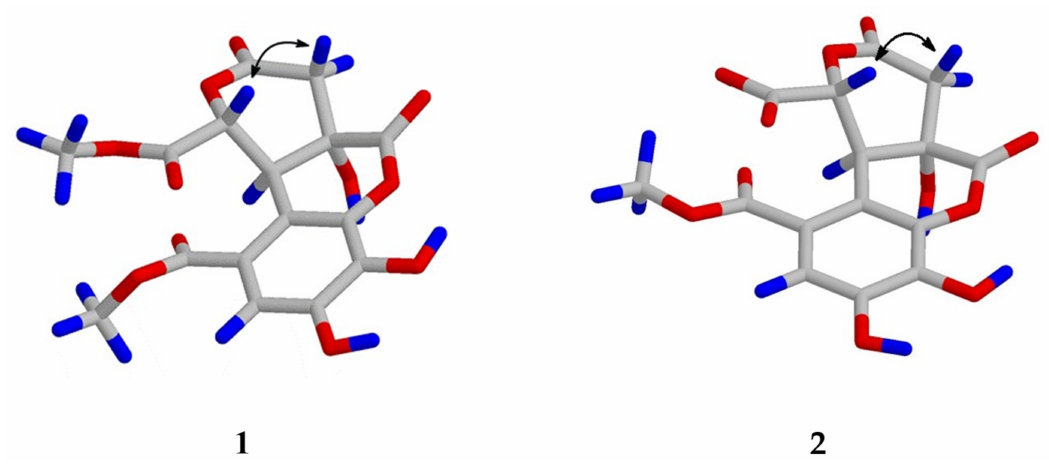
Figure 4. Key NOESY correlations of compounds 1 and 2